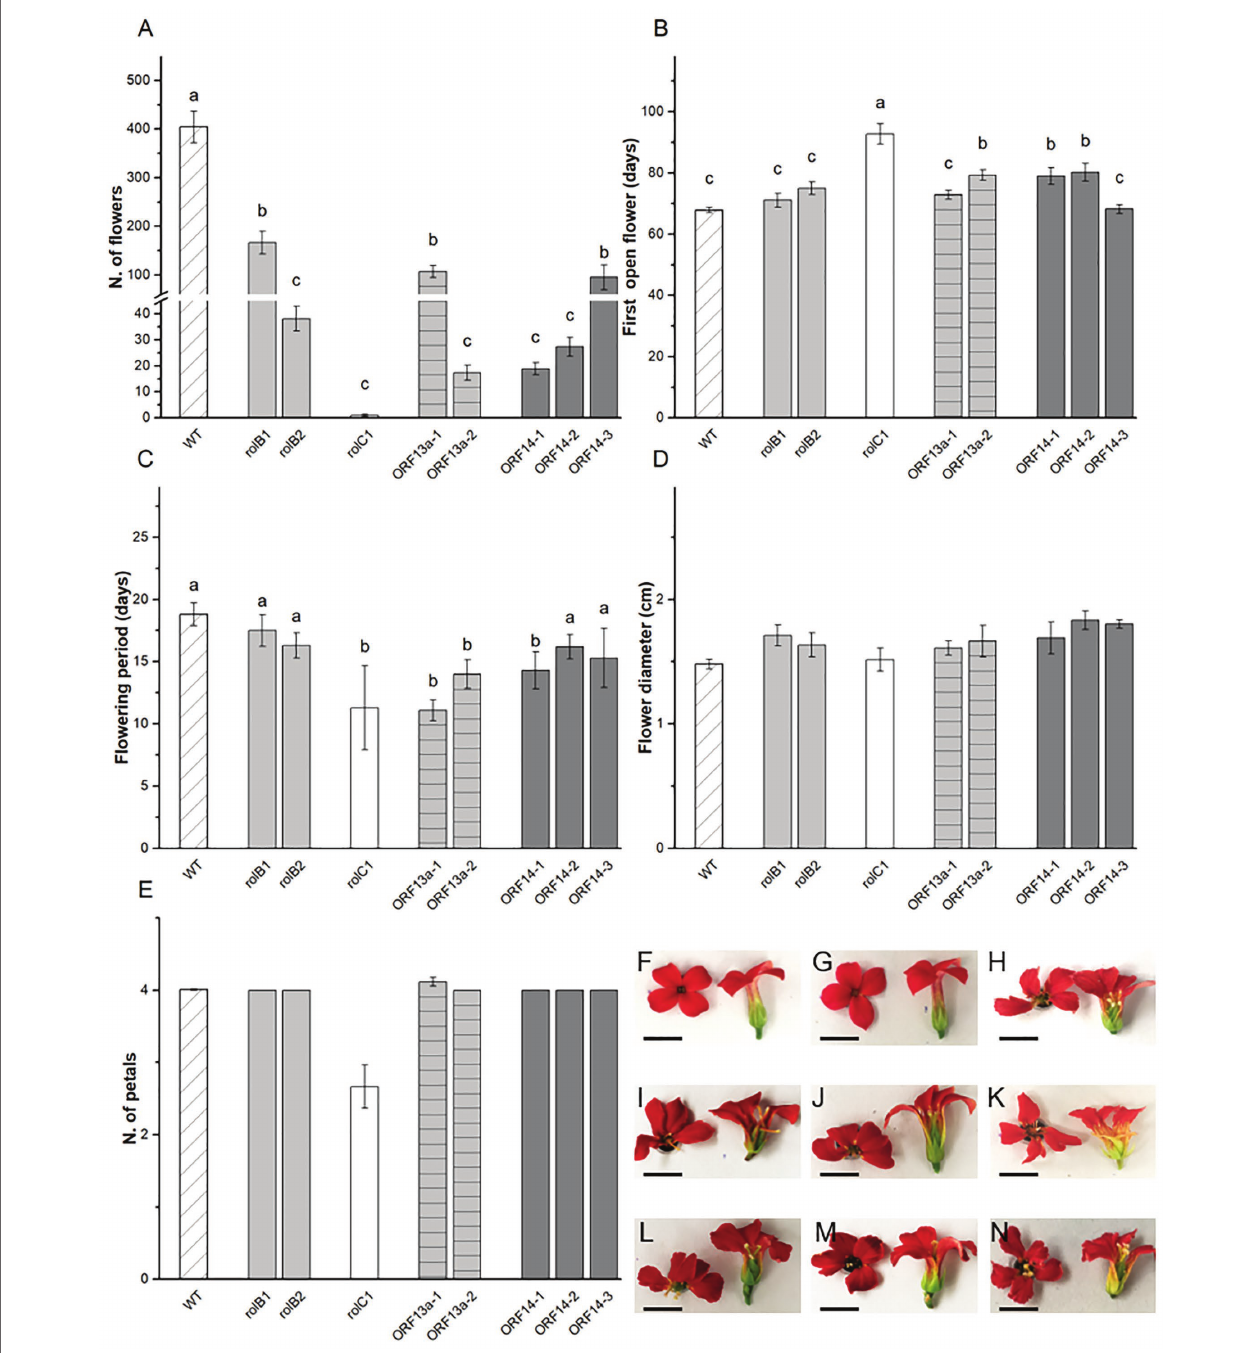
FIGURE 4 | Generative biometric data and flower morphology. (A) Number of flowers, (B) days to first open flower, (C) flowering period, (D) flower diameter, and (E) number of petals of WT K. blossfeldiana ‘Molly’ and overexpressing lines ( rol B1, rol B2, rol C1, Δ ORF13a-1, Δ ORF13a-2, ORF14-1, ORF14-2, and ORF14-3). Data columns represent the average ± SE ( n = 6–27) and different lower case letters represent statistical significance using Scott-Knot test ( p ≤ 0.05). Graphs (E) and (F) were not statistically significant. Representative flower of (F) WT, (G) rol B1, (H) rol B2, (I) rol C1, (J) Δ ORF13a-1, (K) Δ ORF13a-2, (L) ORF14-1, (M) ORF14-2, and (N) ORF14-3 illustrating morphological changes between the lines. Bar = 0.5